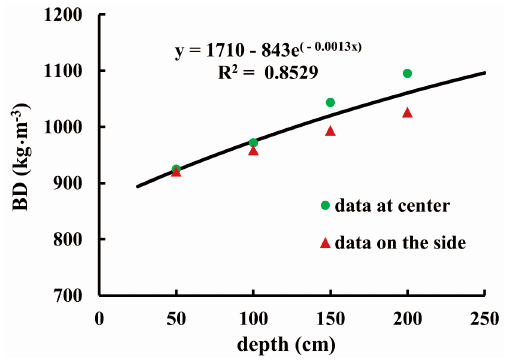
Figure 11. The vertical BD gradient within the bunker silo.